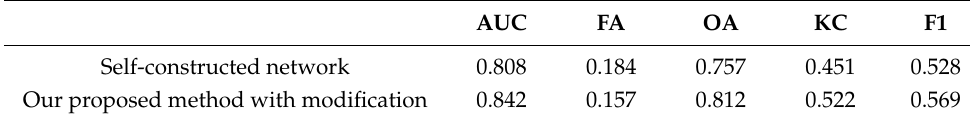
Table 8. The performance comparison for California to show the effectiveness of feature extraction part.